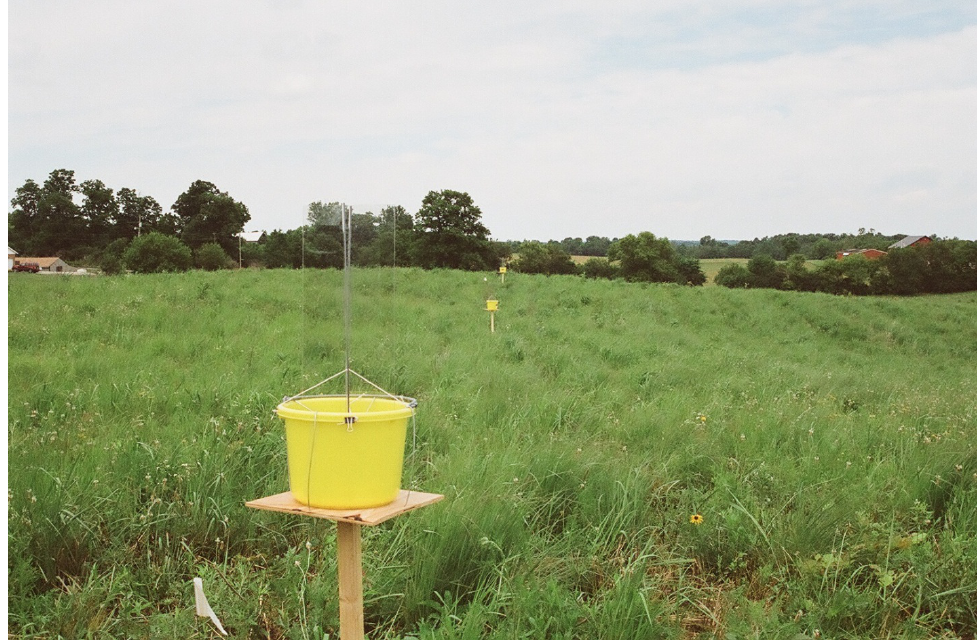
Figure 1. Combined flight-intercept and pan trap used to sample bees and beetles along transects within 10 conservation grasslands in agricultural landscapes of southwestern Ohio, USA. Traps were spaced at 25-m intervals, and a pitfall trap was located within 1 m of each flight trap to sample ground-dwelling